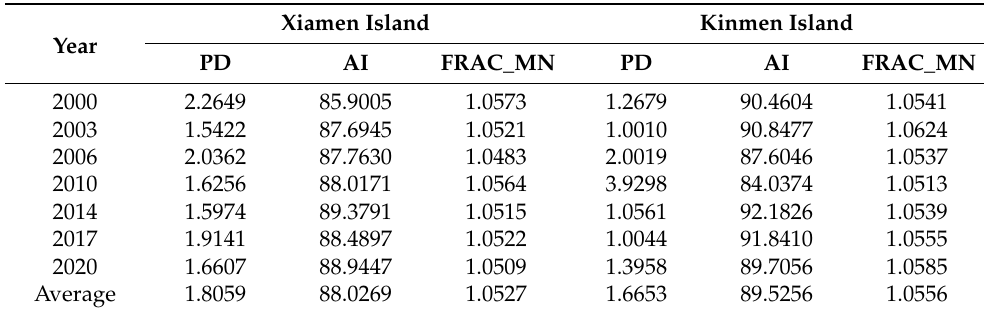
Table 4. Fragmentation, aggregation, and shape complexity of the thermal landscape (HTZ) between Xiamen Island and Kinmen Island in different